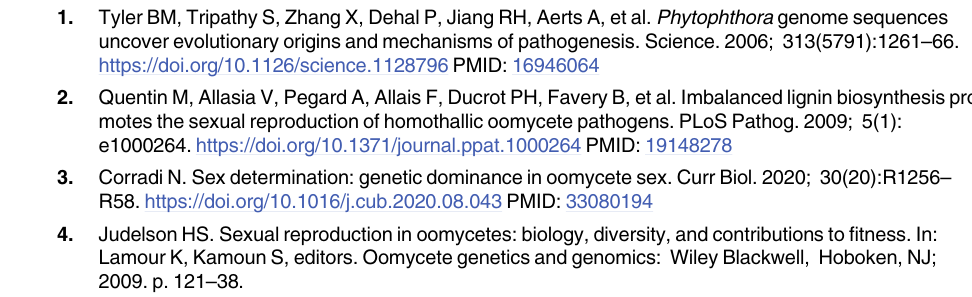
S3 Table. Primers and sgRNAs used in this